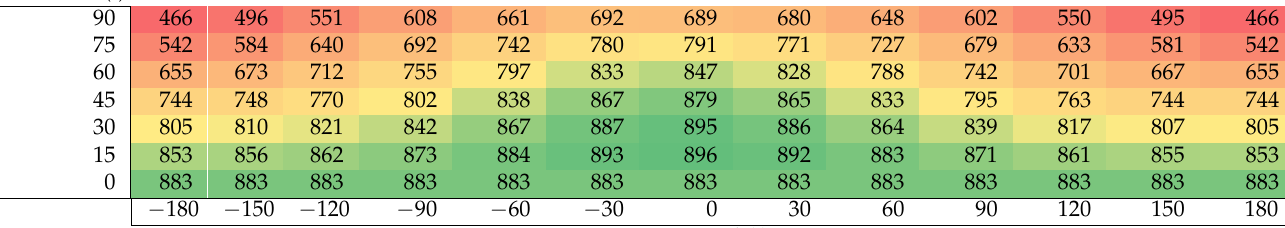
Table 5. Annual self-consumed energy (in kWh year) of a PV installation of 1000 Wp and an obstruction angle of 30 ◦ as a function of the azimuth and inclination of collectors.